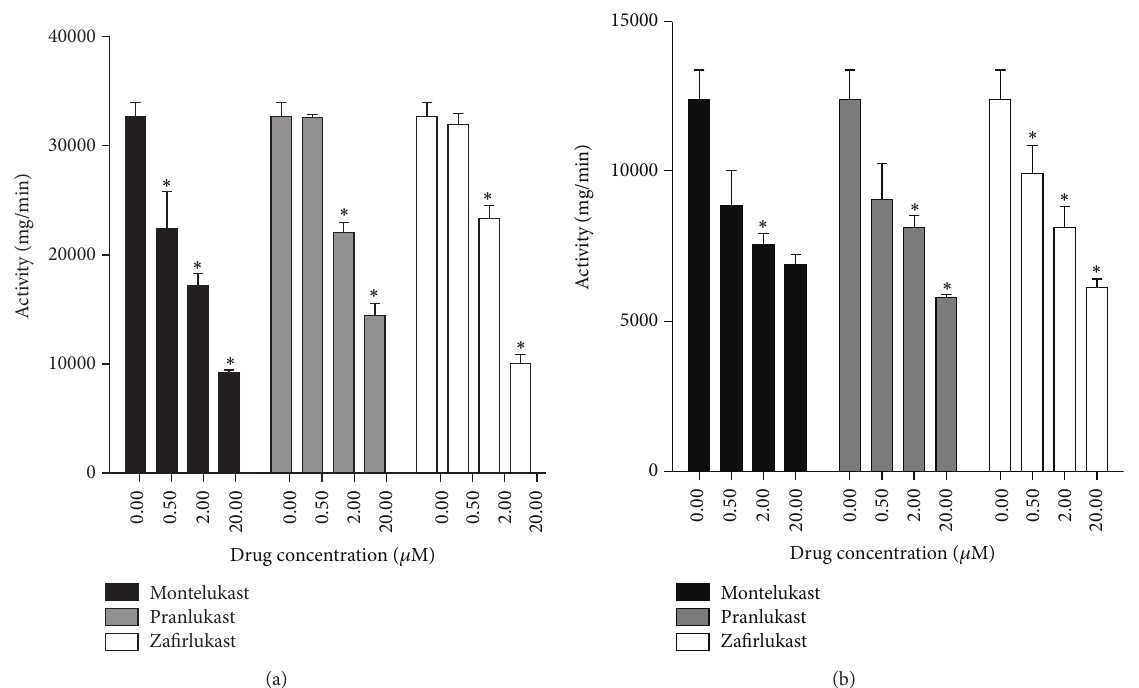
Figure 5: Effects of montelukast, pranlukast, and zafirlukast (0.5–20 𝜇 M) on cAMP- (a) and cGMP- (b) phosphodiesterase (PDE) activities in neutrophil cytosol. The results are presented as the mean enzyme activities, and vertical lines show SEM ( 𝑛 = 2 – 5 , with three to four replicates for each drug concentration and control system in each experiment). ∗ 𝑃 < 0.05 for comparison with the corresponding drug-free control